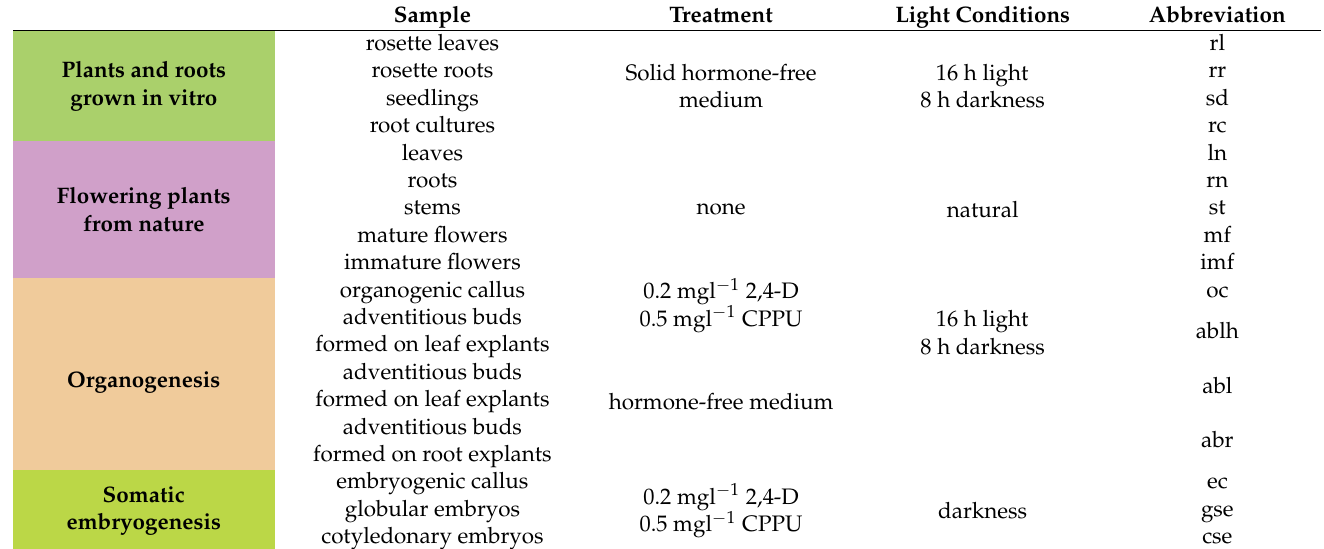
Table 1. C. erythraea tissue samples used for AGP expression analysis. 2,4-D-2,4-dichlorophenoxyacetic acid; CPPU-N-(2- chloro-4pyridyl)-N (cid:48) -phenylurea. Sample Treatment Light Conditions Abbreviation rosette leaves Solid hormone-free